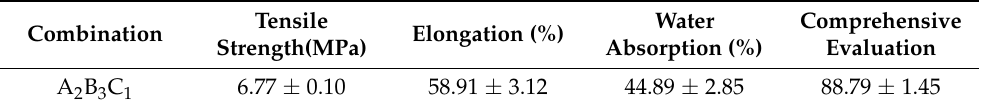
Table 3. The validation results of the A 2 B 3 C 1